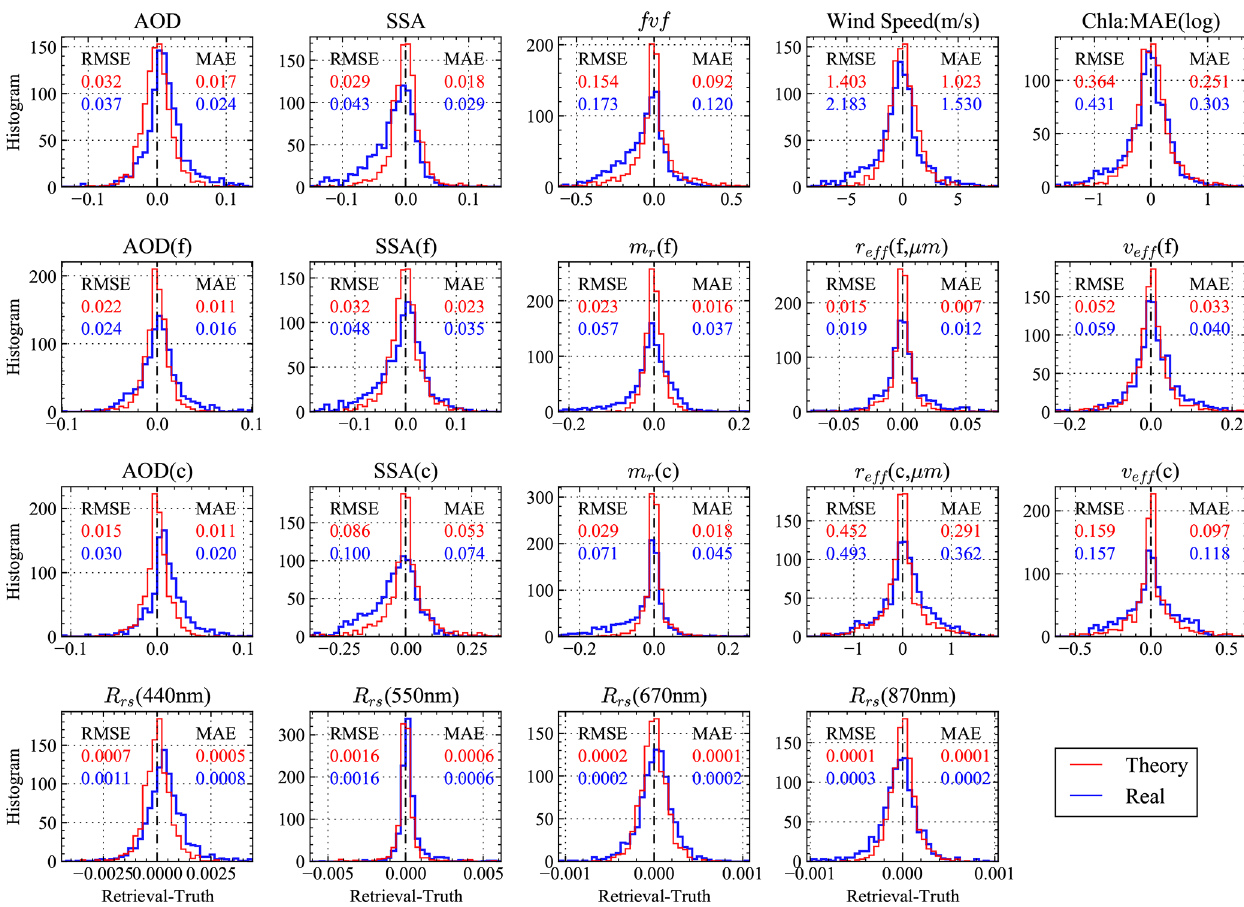
Figure 6. Histograms of the theoretical and real retrieval errors evaluated using the MCEP method in Sect. 3.2 for the same cases as in Fig. 5.